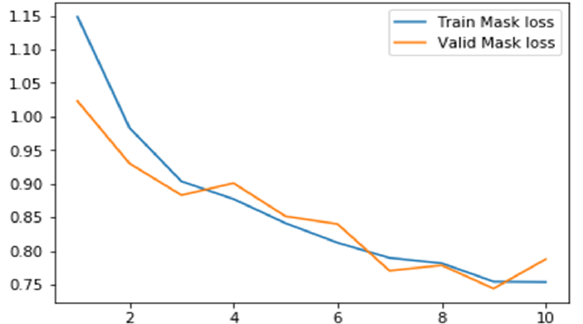
Figure 18. Mask loss scores for the proposed model with LR 0.0006, Epochs =